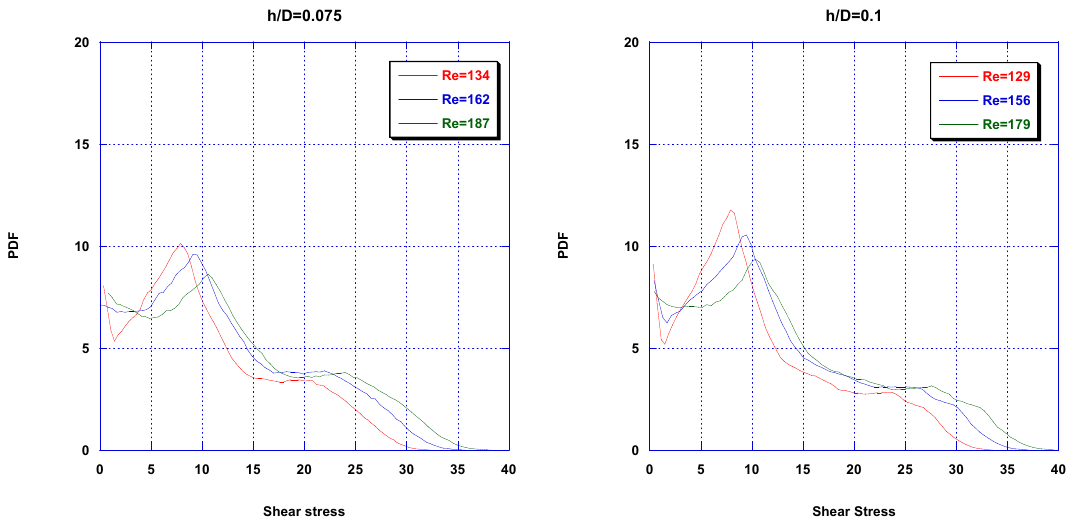
Figure 9. Probability density function of the dimensionless local, time-averaged shear stresses on the membrane surface for the four cases of fouling-layer thicknesses examined in this work. Shear stresses are normalized with the quantity μ U / D .